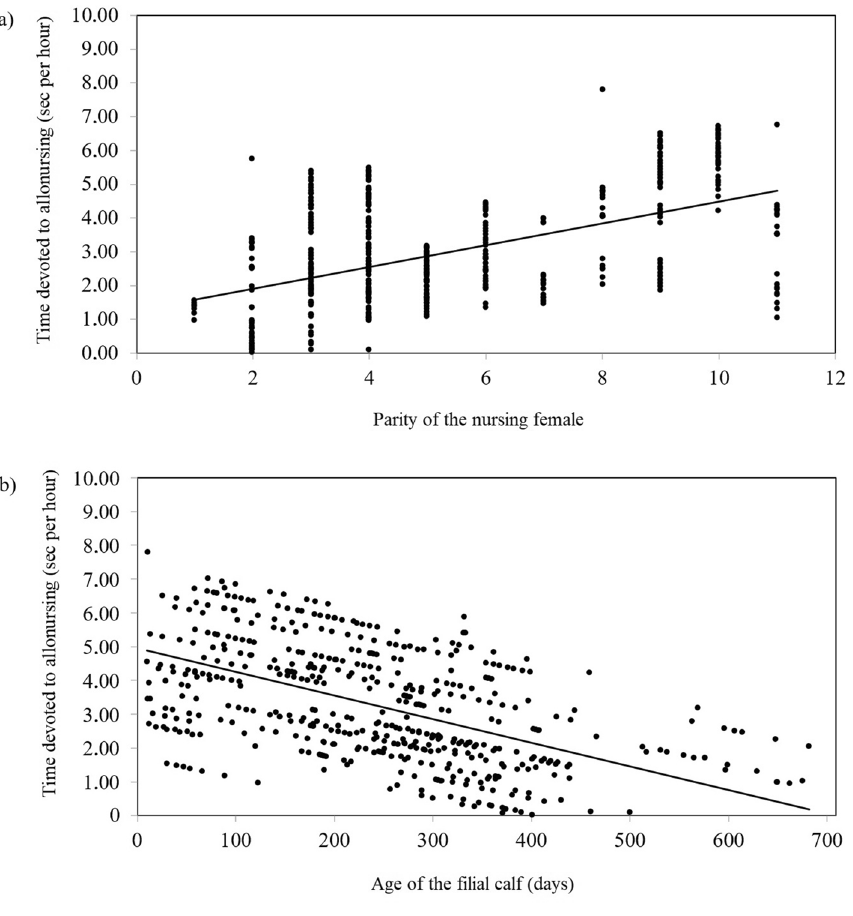
Figure 2. The time which a female devoted to allonursing increased with the increasing parity of the female ( a ), while it decreased with the increasing age of the filial calf ( b